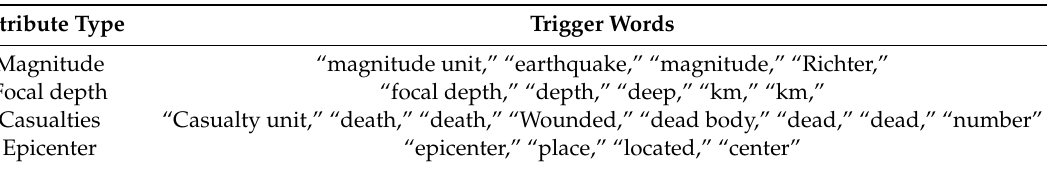
Table 4. Attribute trigger